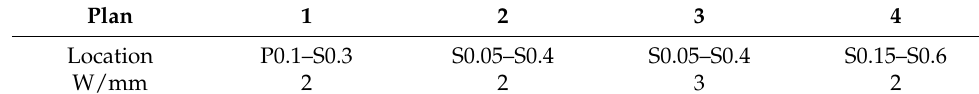
bg with various suppression